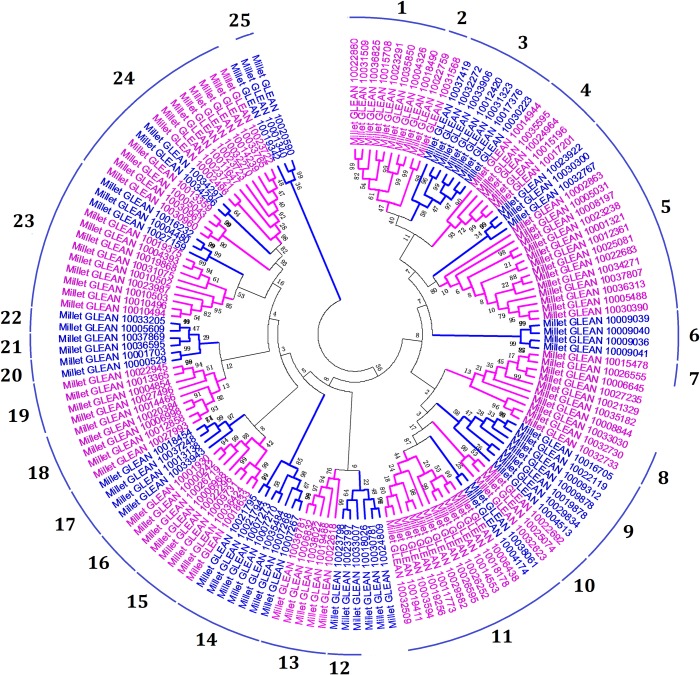
Neighbor-joining phylogenic analysis of bHLHs in foxtail millet.The numbers on the discontinuous cycle represents the names of clades (clades 1–25).